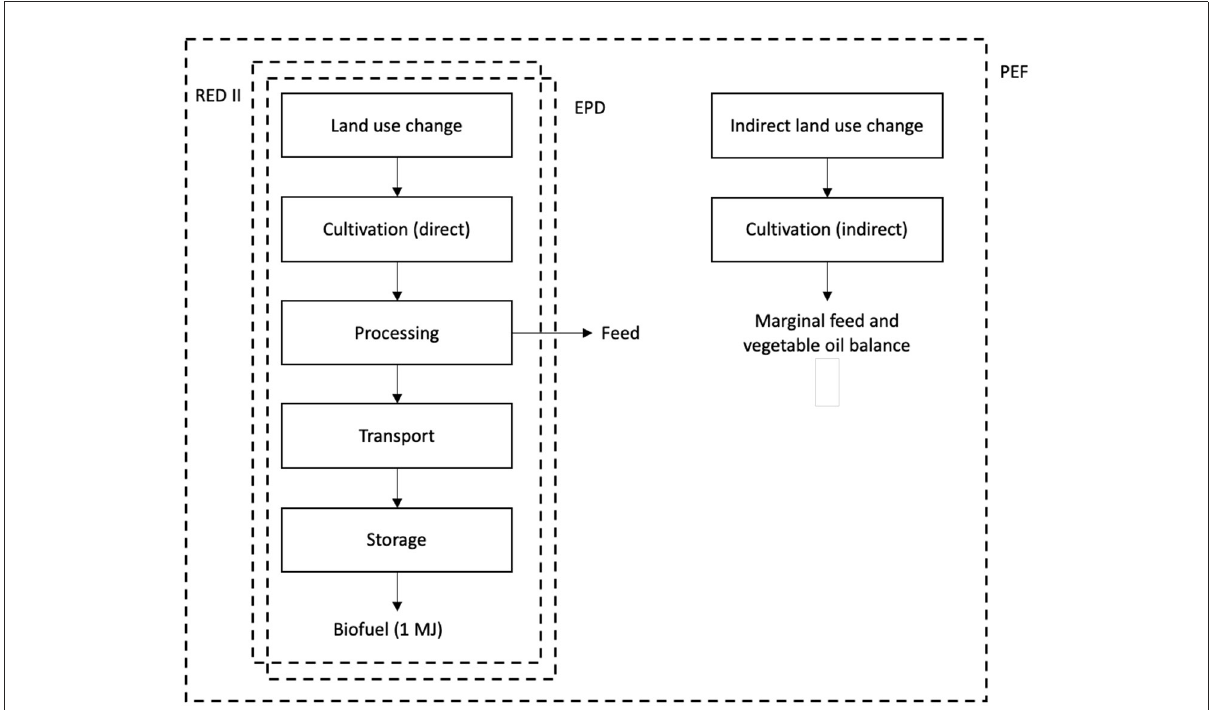
FIGURE1 System boundaries in relation to the methods applied: RED II, EPD, and PEF. RED II and EPD exclude by-products and their fate by applying energy allocation, while PEF allows for the substitution approach and considers changes in the cultivation and LUC of the marginal crops affected by the DDGS or rapeseed cake, which is used as an animal feed. As a result, the balancing of the feed and vegetable oil markets is included in our PEF